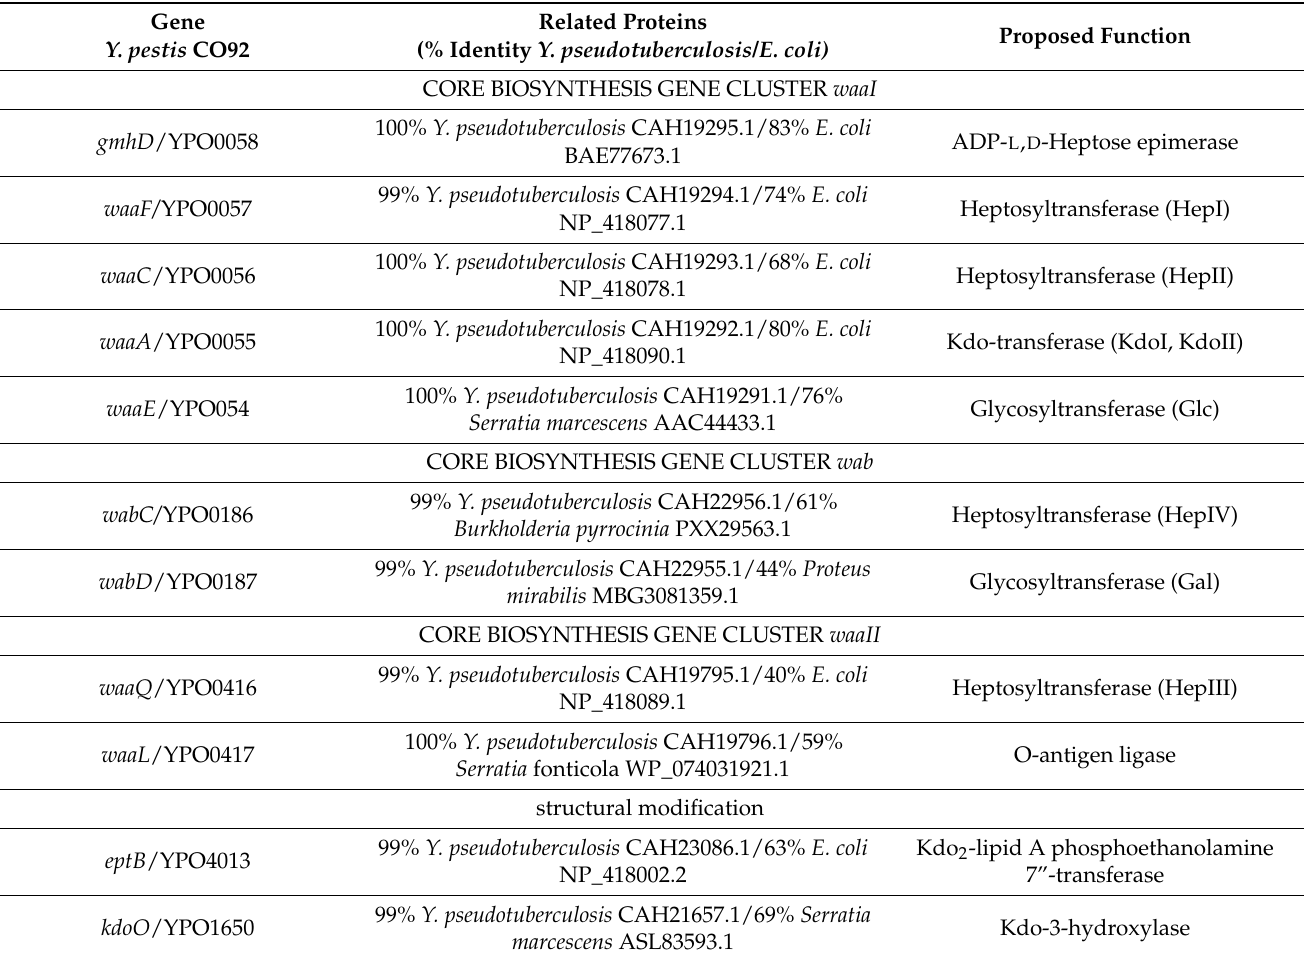
Table 4. Homologues of Y. pestis core OS biosynthesis genes found in the Y. pseudotuberculosis / E. coli genomes. Sequence conservation relates to alignments with the Y. pseudotuberculosis IP 32953 and E. coli K-12 sequences [35,48–50]. Gene Y. pestis